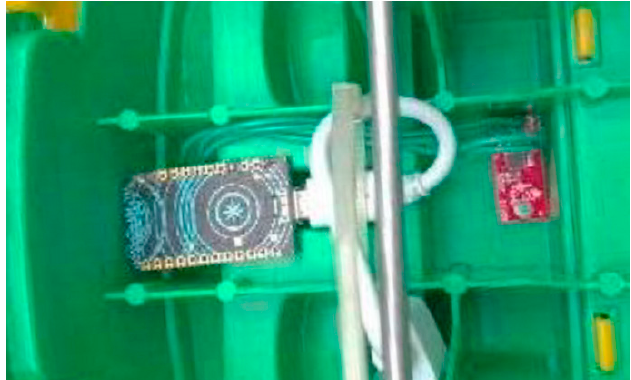
Figure 1. Detail of a sensor installation in a toy truck.